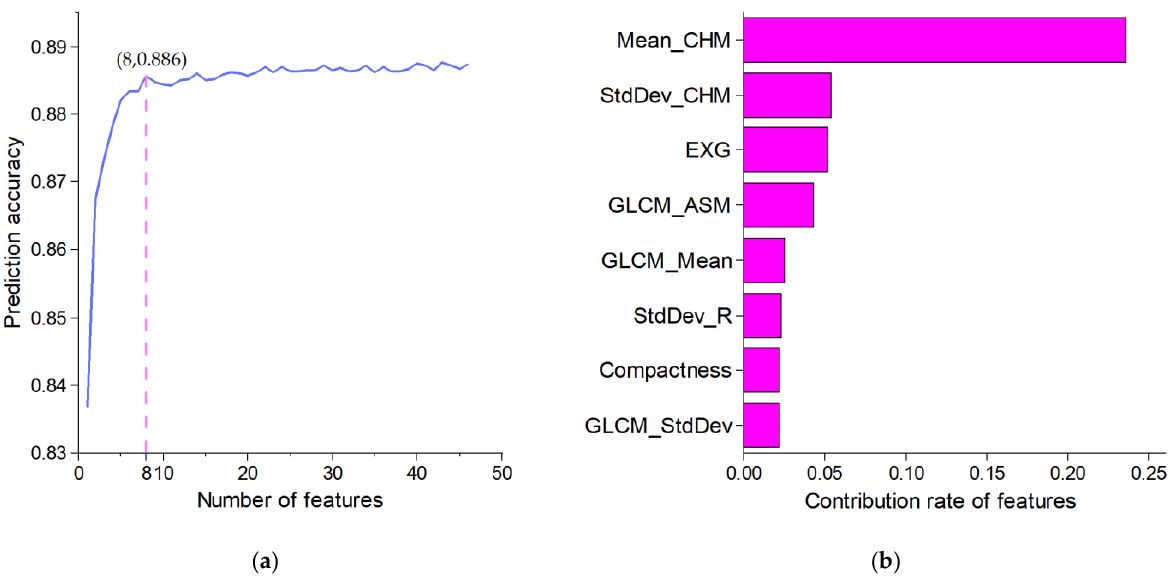
Figure 7. RFE feature optimization: ( a ) relationship between number of features and prediction accuracy; ( b ) top 8 features of importance and contribution rate of accuracy.